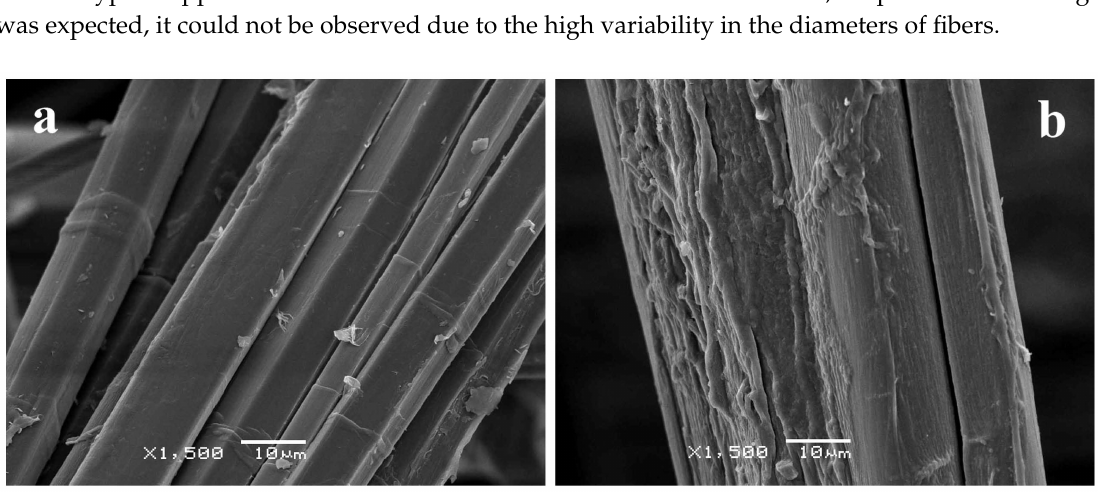
Figure 1. SEM images of ( a ) untreated; and ( b ) wet/dry cycled flax bundles taken at 10 kV and ˆ 1500